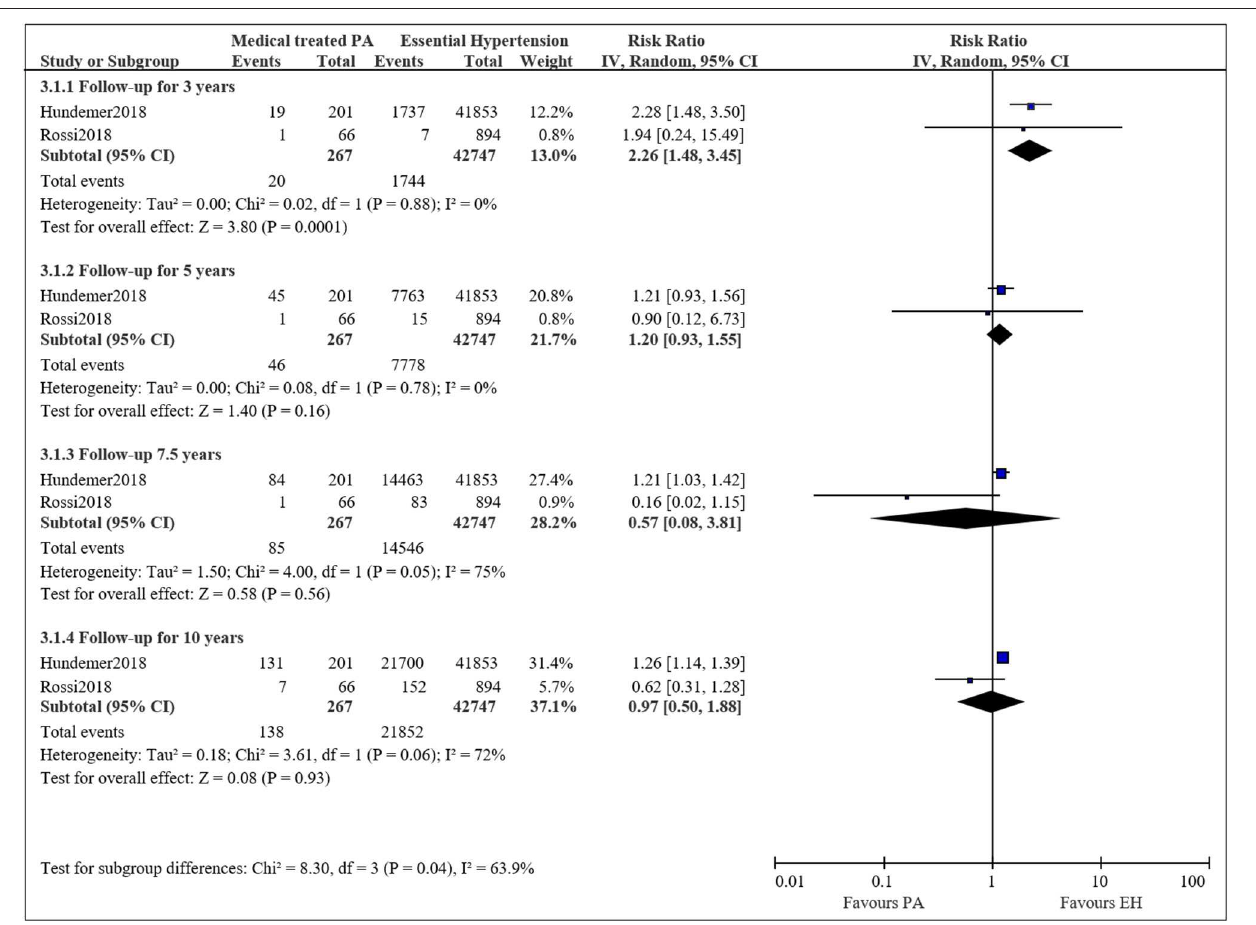
FIGURE 4 | Comparison of patient with medical treated PA and EH of the risk of mortality at different follow-up